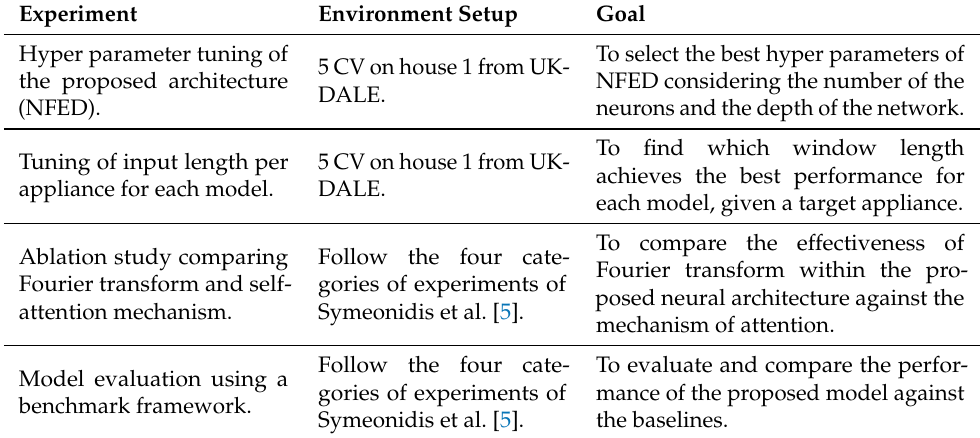
Table 1. Summary of